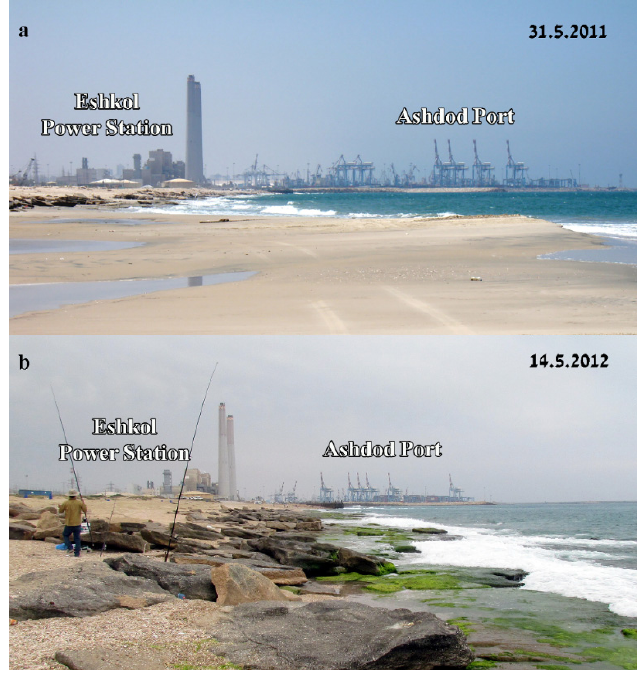
Figure 3. The rocky (beachrock) coast north of Ashdod Port: ( a ) during the nourishment operation